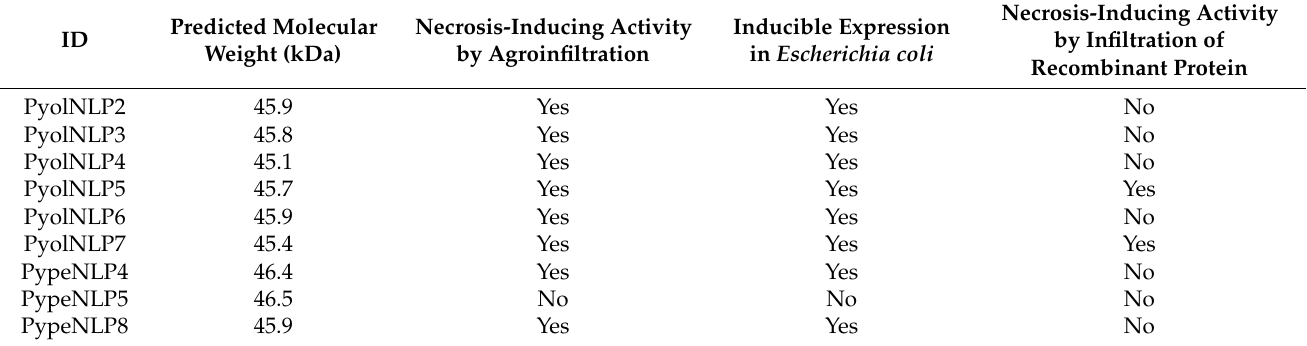
Table 1. Summary of the necrosis-inducing activity of partially purified NLP proteins in Nicotiana benthamiana . Predicted ID